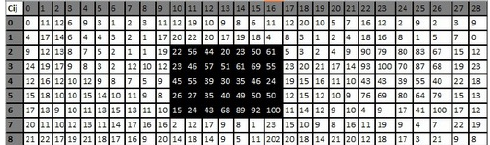
Figure 17: Zone with an homogeneous degrees of dirt